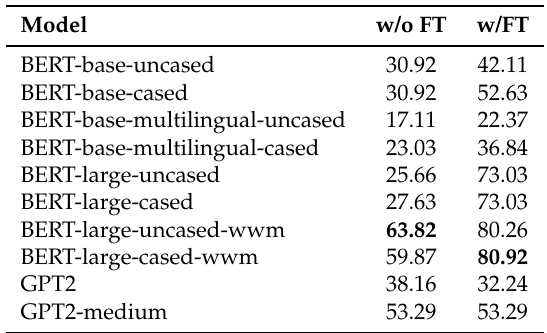
Table 7. Accuracy results (%) of transformer-based models for the SAT set with and without fine-tuning, which are presented in w/o FT and w/FT columns,